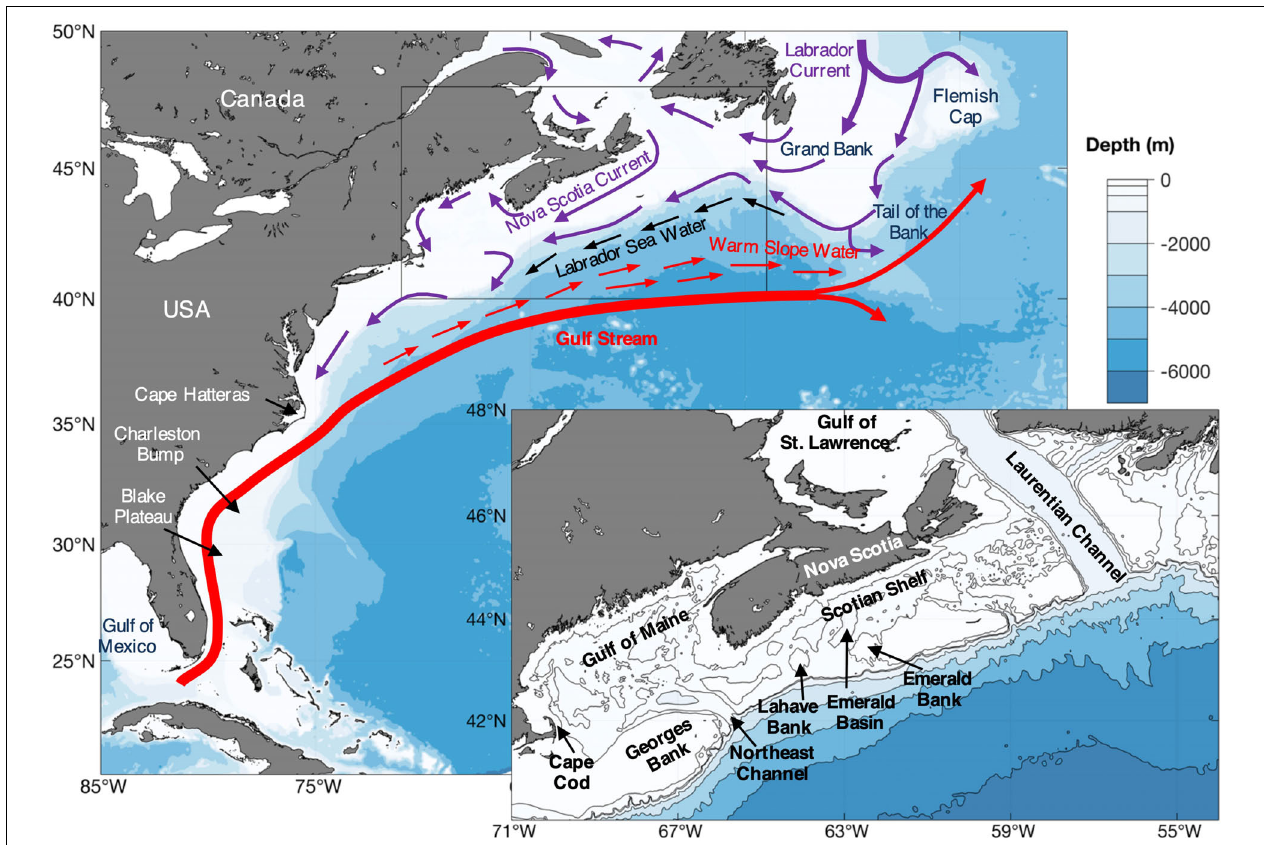
FIGURE 2 | Geographic place names, general position of major currents and water masses, topography, and undersea features in the study area. The inset area is outlined in gray on the large map. See also Figure 1 and Supplementary Figure 1 .